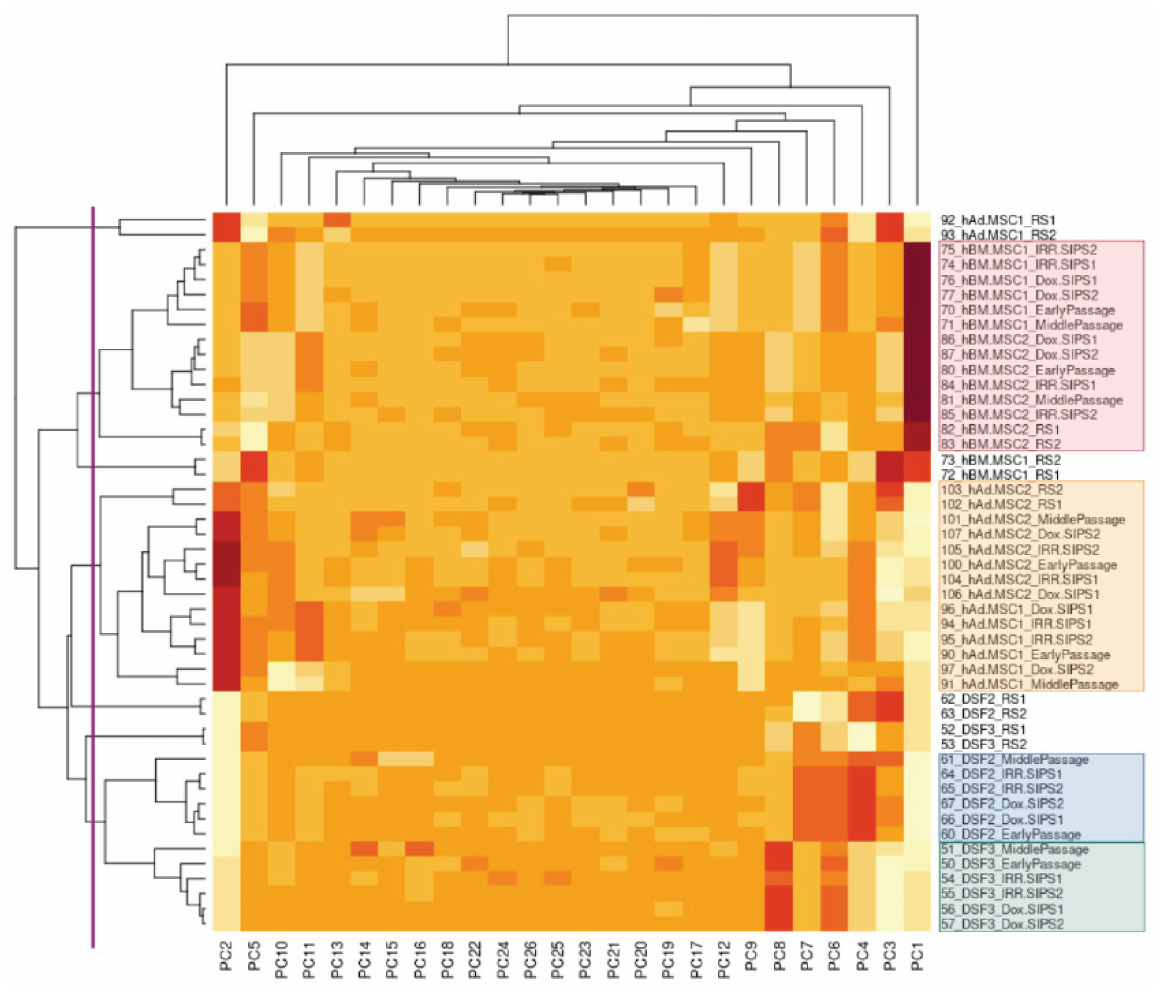
Figure 1. Heat map of principal component analysis (PCA) of DNA methylation data for the entire studied cohort. Vertical axis corresponds to analyzed samples: on the right, sample names are listed, while on the left, the dendrogram of sample clustering is plotted. Horizontal axis corresponds to principal components (PCs): on the bottom, the 26 components used are specified, while on the top, the dendrogram of PC clustering is presented. Purple vertical line marks the depth of sample clustering considered, and colored blocks highlight the obtained sample groups. On right, sample names are listed (numbers from 51 to 106) with indication of cell origin (DSF, hBM-MSC, hAd-MSC) and sample condition (EarlyPassage, early-passage cells; MiddlePassage, cells after a middle number of passages; RS, cells in replicative senescence; IRR.SIPS, cells in stress-induced premature senescence after exposure to ionizing irradiation; Dox.SIPS, cells in stress-induced premature senescence after exposure to